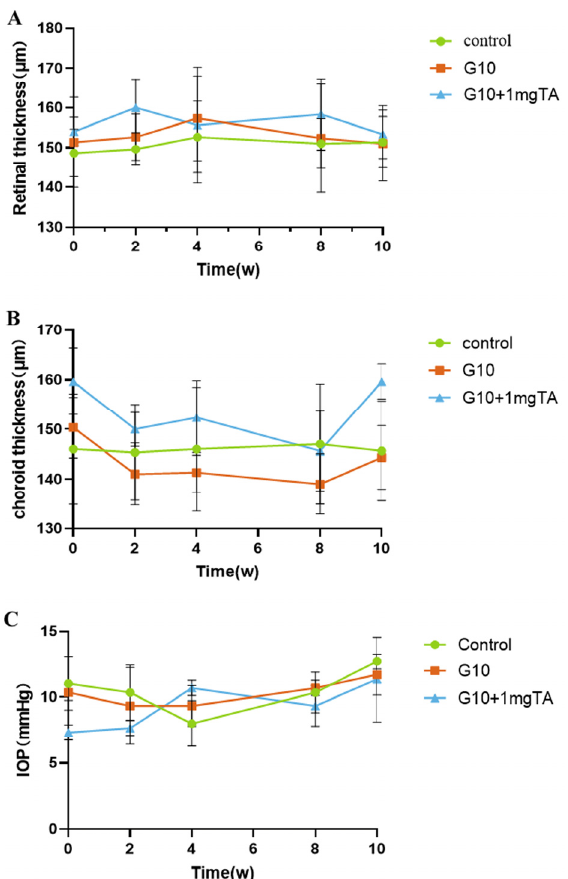
Figure 8. Quantitative analysis of changes in retinal/choroid thickness and intraocular pressure occurring throughout the study. Retinal thickness ( A ) and choroid thickness ( B ) was measured by OCT over the course of the study. ( B ) Choroid thickness was measured by OCT over the course of the study. ( C ) Change in IOP when the GelMA-TA system was injected into rabbits.